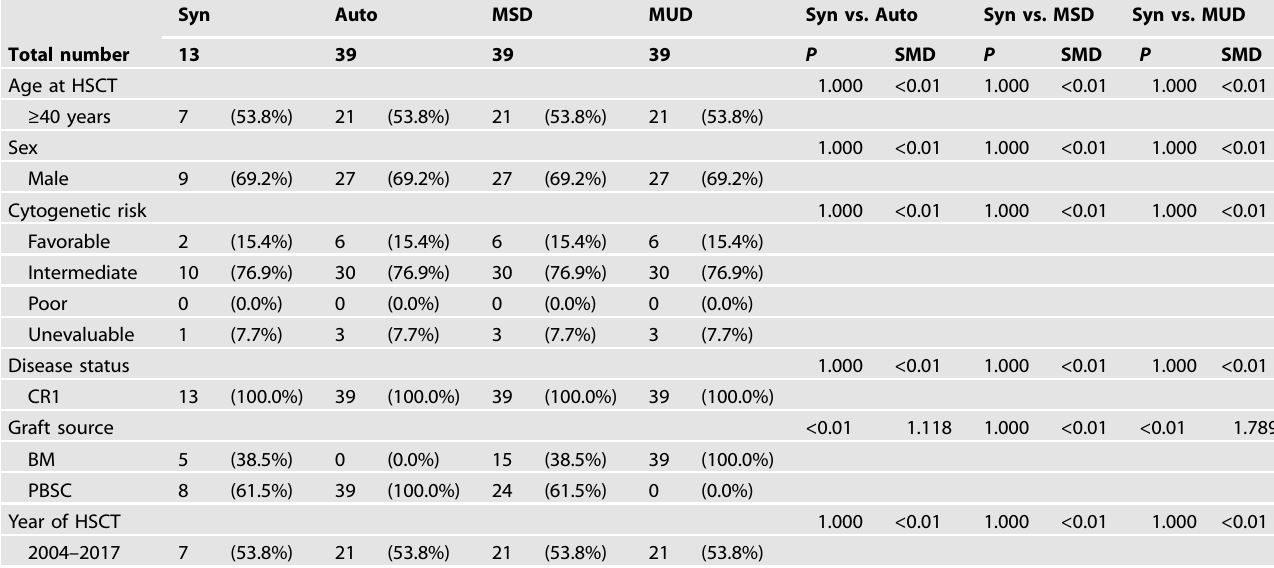
Table 2. Patient characteristics after propensity score matching.